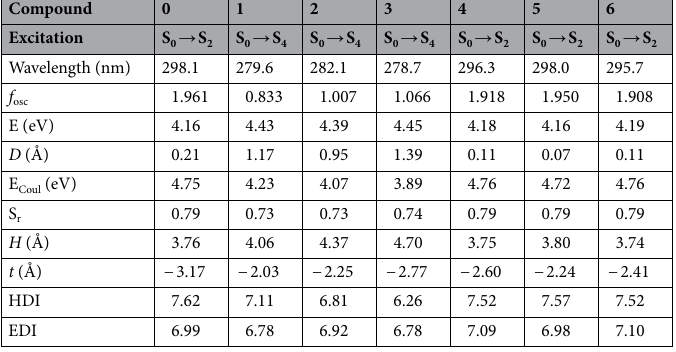
Table 5. Hole-electron analysis indices for the excitations with highest f osc of compounds 0 and 1 – 6 .